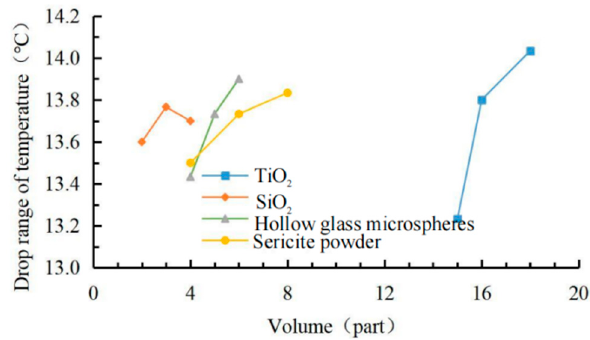
Figure 4. Factor effect of viscosity.